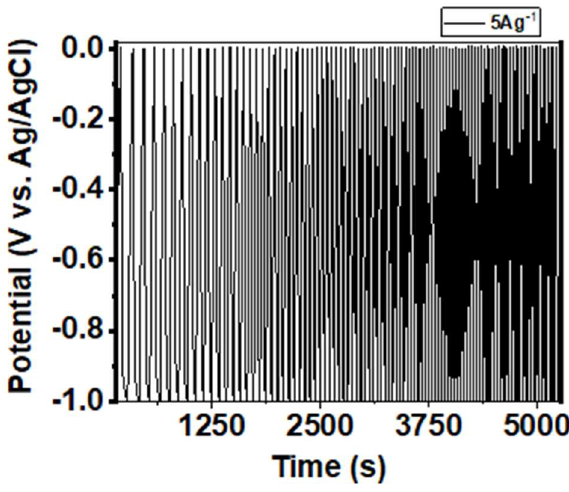
Figure A2. Stability test results for 5000 charge–discharge cycles at a current density of 5 A/g.